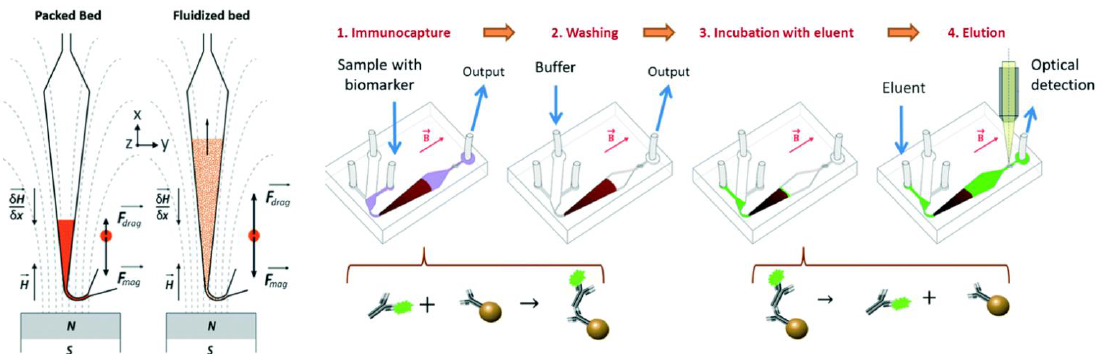
Figure 17. Schematic illustrations of the microfluidic fluidized bed for two working regimes: at low imposed pressure, particles are organized in a packed bed. When drag forces associated with the flow compensate for magnetic forces, fluidization of particles occurs. The volume of the bed can